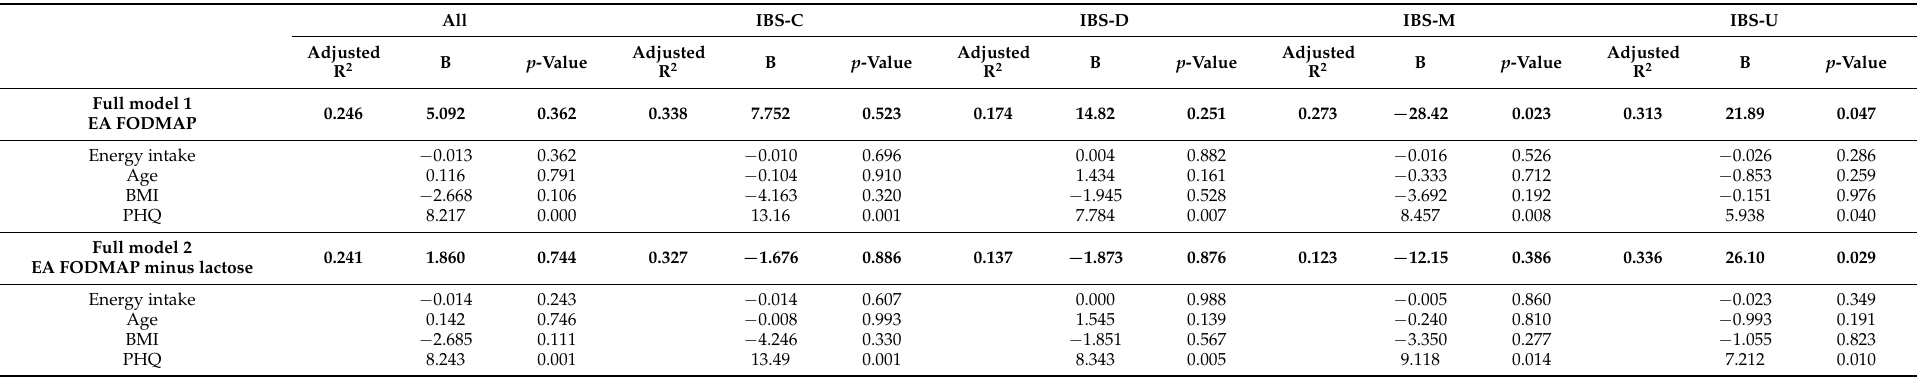
Table 5. Multivariable linear regression for women with IBS studying the associations between FODMAP intake (energy-adjusted, quartiles) and IBS symptom severity.